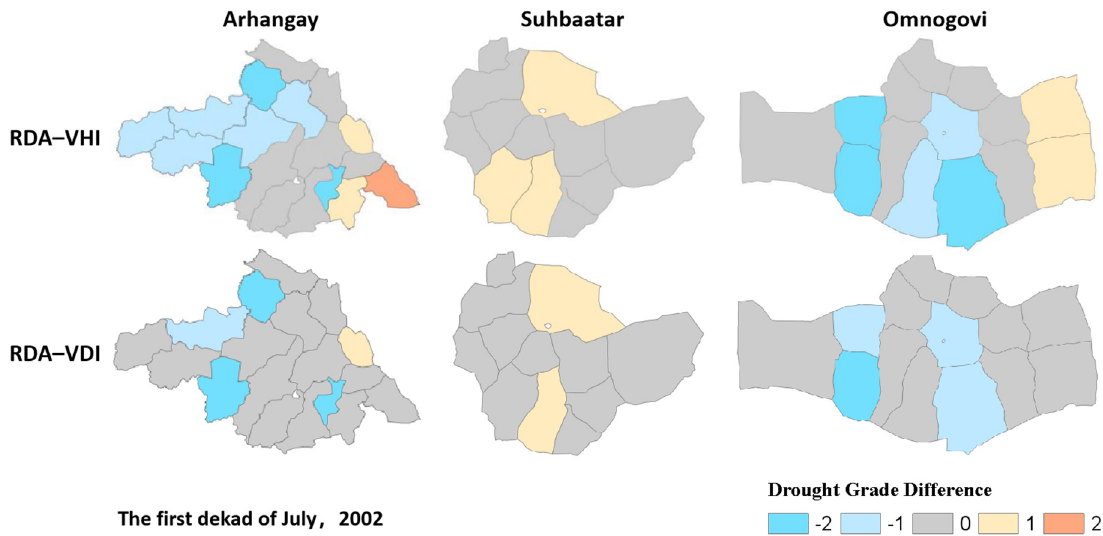
Figure 7. Drought grade differences between the averaged VHI, VDI, and RDA (RDA–VHI, RDA–VDI) at the county level in the first dekad of July, 2002, for three typical provinces.